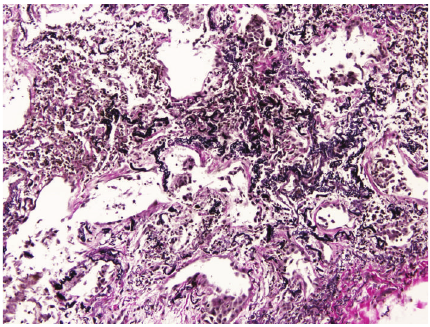
Figure 3: Histopathology of Case 1 (transbronchial cryobiopsy) showed abundant elastic fibers. Weigert Van Gieson stain